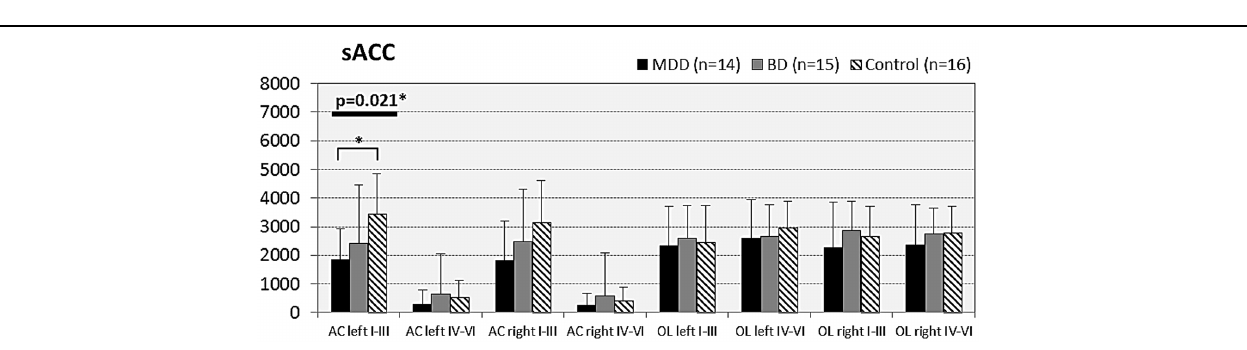
FIGURE 4 | Numerical densities of GS-expressing glial cells (ACs and OLs) in the sACC of subjects with MDD, BD, and controls. Compared with controls the density of GS-expressing ACs is significantly reduced in MDD cases (AC left I–III, p = 0.021).